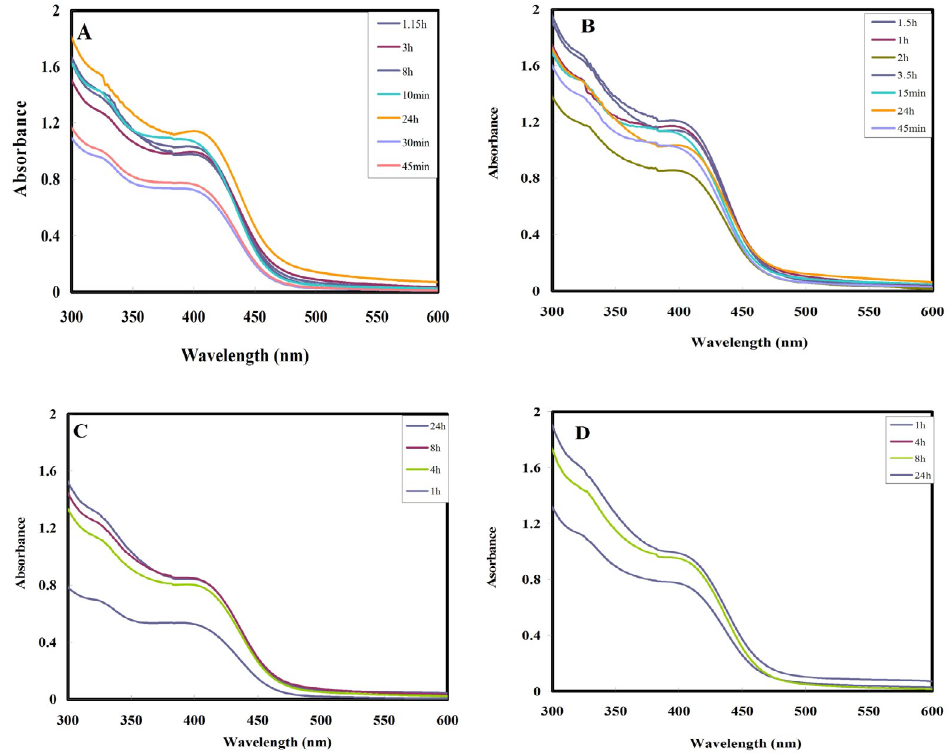
Fig. 3. UV-Vis absorption spectra of the Ag nanostructures prepared at different conditions: (A) 90 W, (B) 270 W, (C) 450 W irradiation power, (D) maceration.